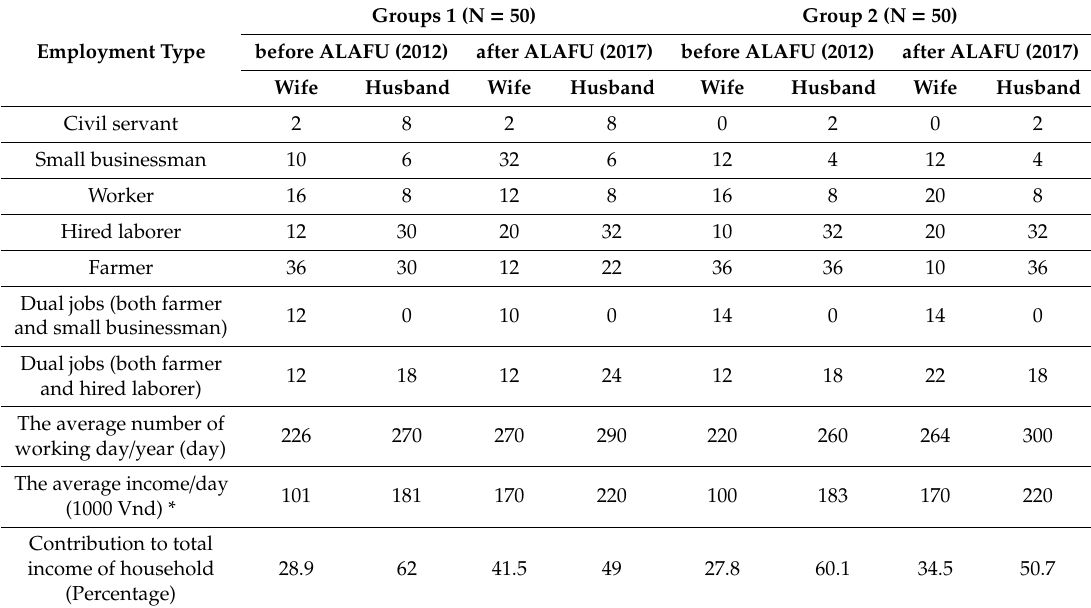
Table 2. Changes in employment and income of wife and husband (Percentage of